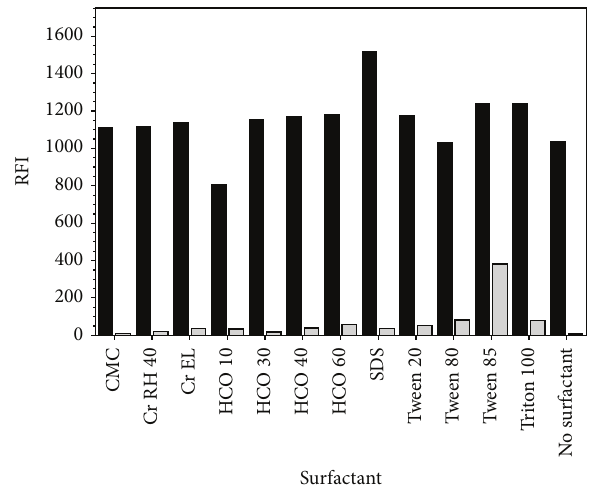
Figure 3: Effect of the type of organized media (0.5mL 1% w/v solution of each) on RFI of MRZ (100ng/mL) (black column MRZ- SLS, white column MRZ alone).